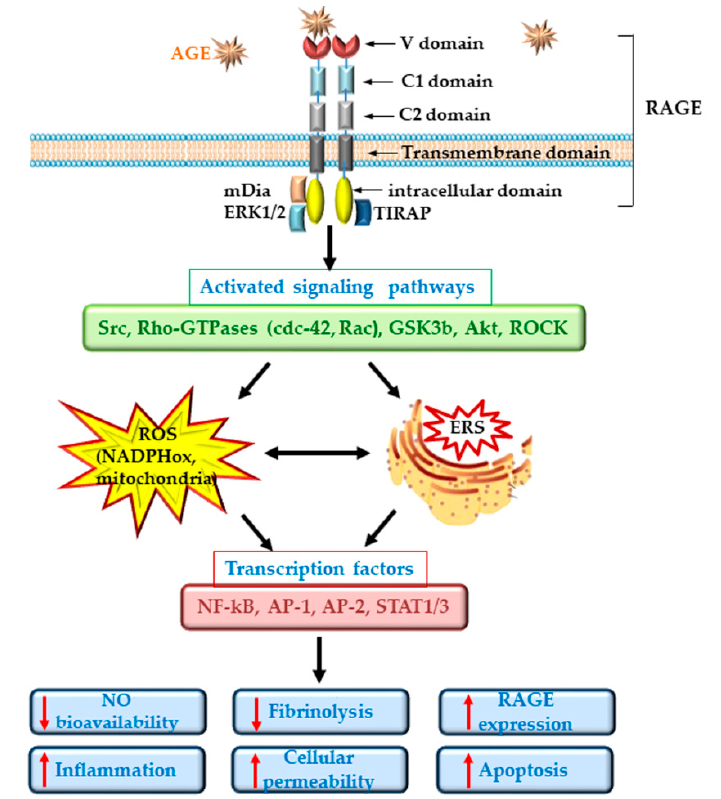
Figure 1. Formation of irreversibly glycated lipoproteins by Maillard reactions.